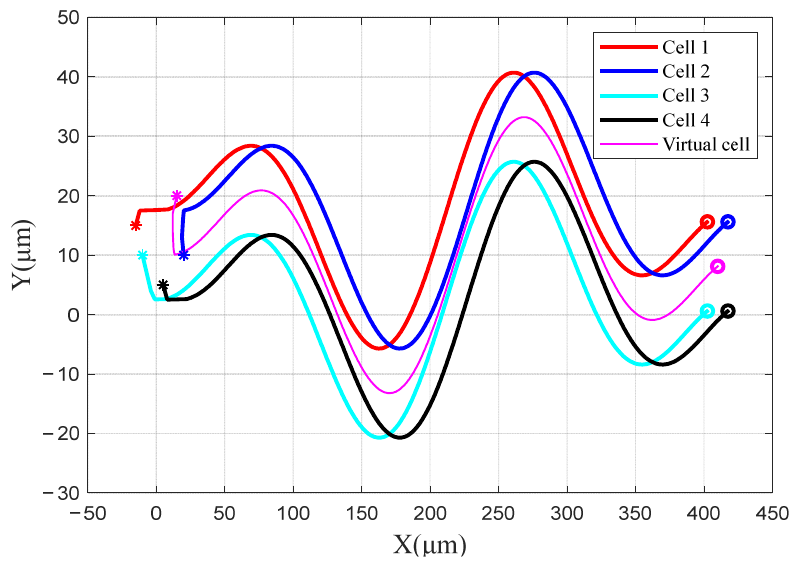
manipulate multiple cells are shown in Figure 10.